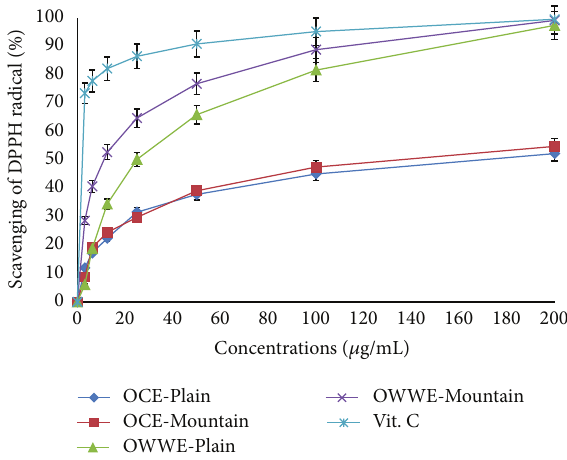
Figure 3: Kinetics of DPPH radical scavenging activity of OCE and